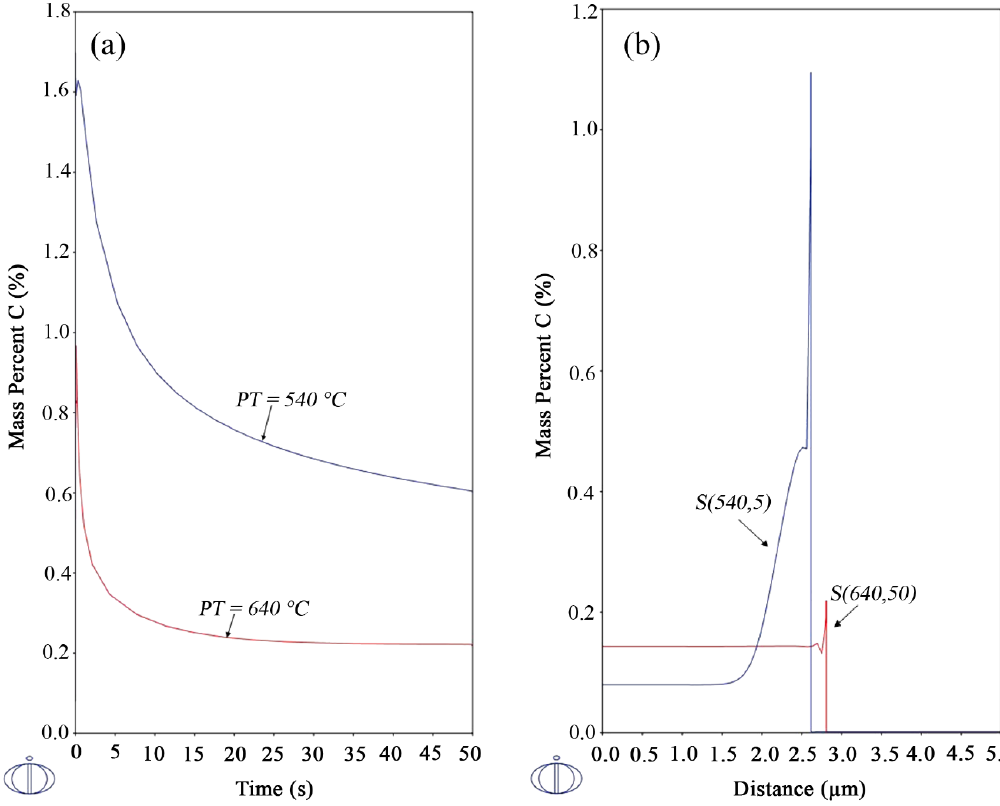
Figure 6. Comparison of samples partitioned at 540 °C, 5 s (blue) and 640 °C, 50 s (red), calculated using Dictra. ( a ) The composition of the interface as a function of the time; ( b ) carbon content vs. location γ/α interface is at 3 μ m distance).